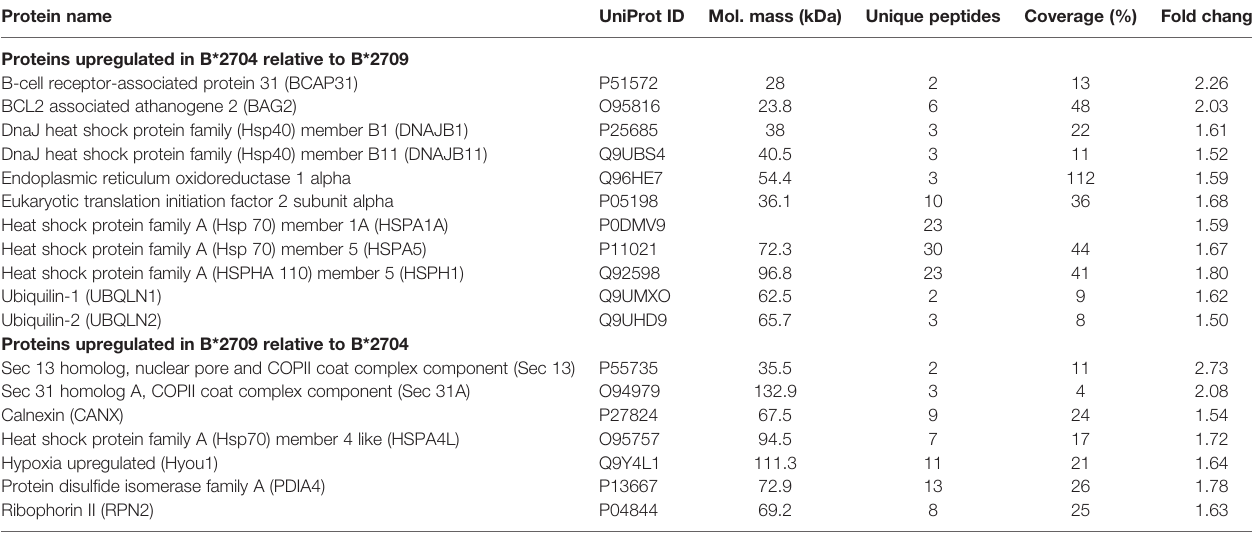
TABLE 1 | Statistically signi fi cant differentially expressed proteins classi fi ed under the KEGG pathway, protein processing in ER. Protein name